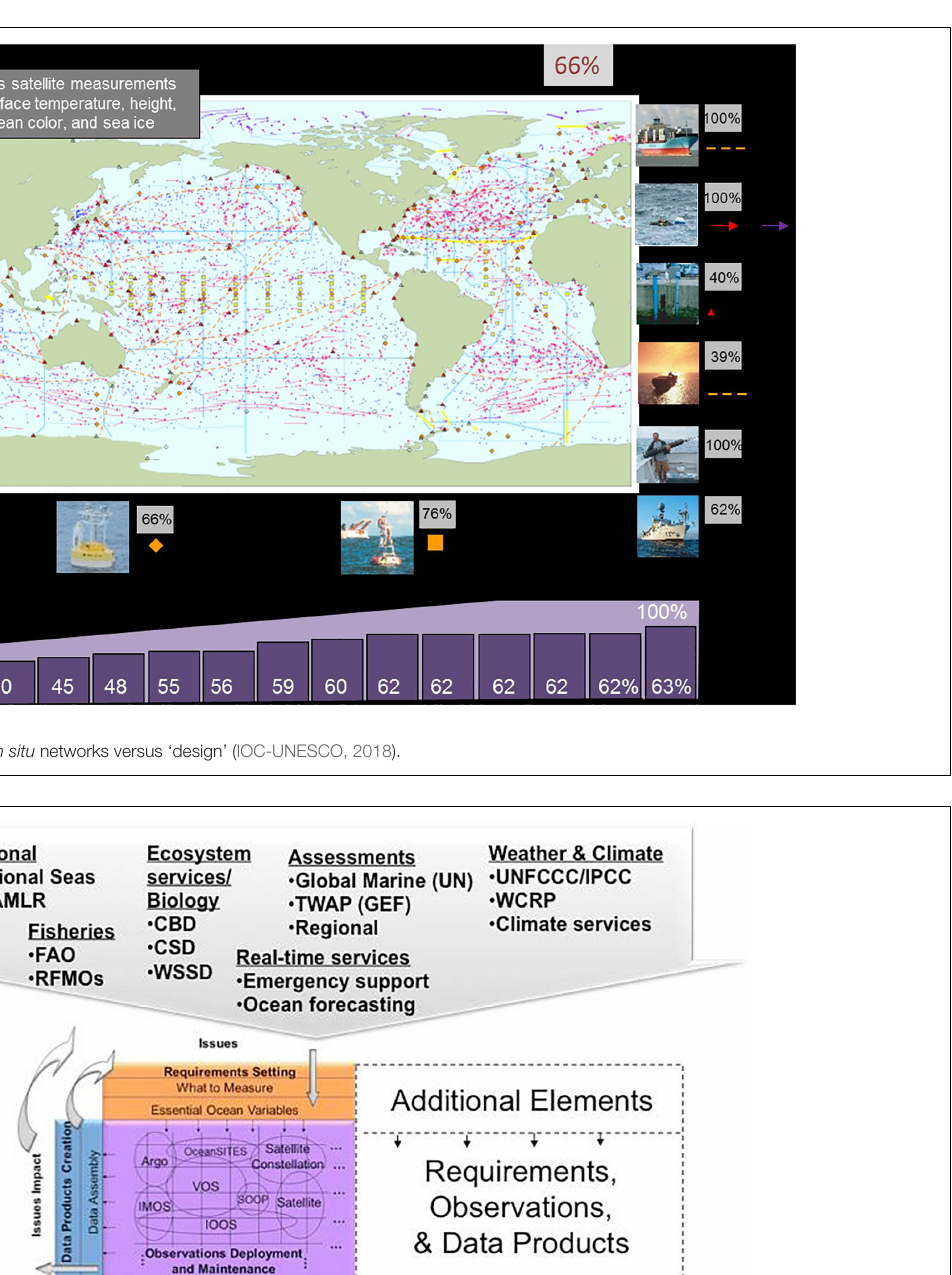
FIGURE 2 | Framework for Ocean Observing, societal drivers for the next decade (Lindstrom et al., 2012).